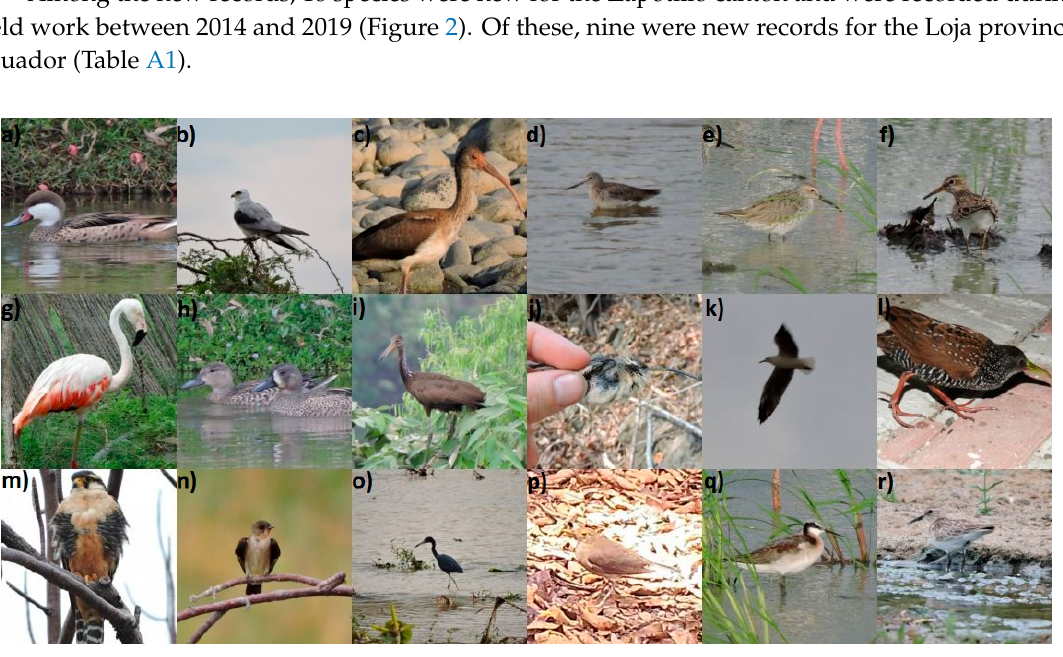
Figure 2. New bird species records in the Zapotillo canton, Loja, southwestern Ecuador. The first nine species (a–i) were also new records in Loja province, South of Ecuador.